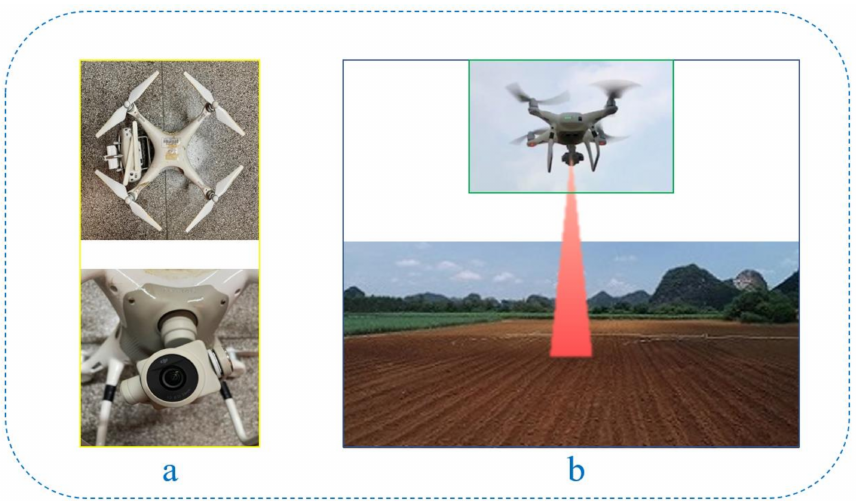
Figure 2. Data-collecting platform. ( a ) UAV and RBG camera. ( b ) Collection of images of sugarcane